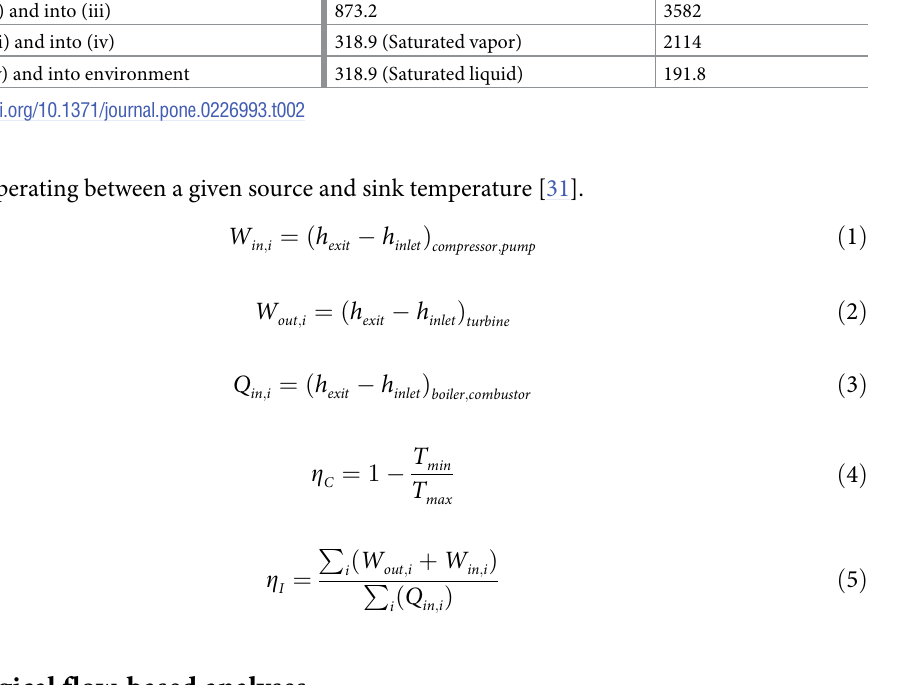
Table 2. Energy information (kJ/kg) used to fill in the flow matrix [T] for the simple Rankine cycle of Fig 1, calcu- lated using the temperature and pressure information in Table 1. T (K) h (kJ/kg) into (i) 318.9 (Saturated liquid) 191.8 out of (i) and into (ii) 319.5 out of (ii) and into (iii) out of (iii) and into